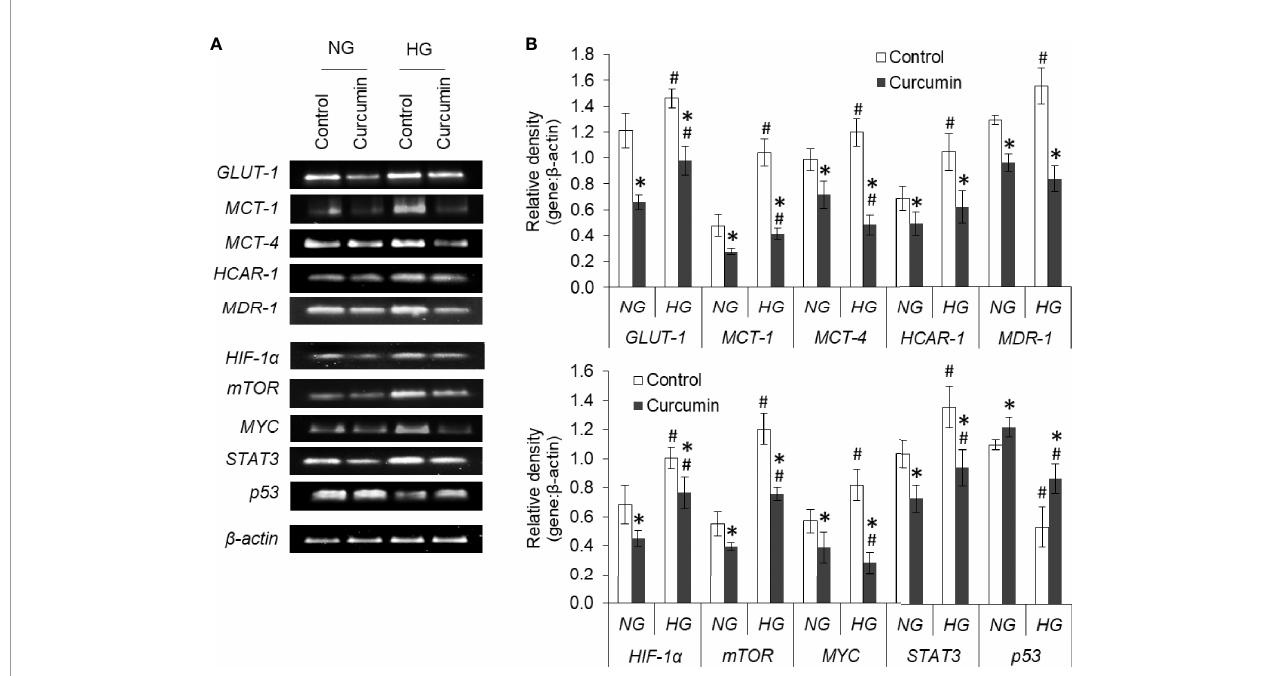
FIGURE 12 | Curcumin modulates the gene expression of regulators of metabolic and chemoresistance phenotype of cancer cells. Cells incubated in NG or HG medium with and without curcumin were processed for RT-PCR analysis for gene expression of regulators of metabolic and chemoresistance phenotype as indicated. The ampli fi ed DNA were resolved on Agarose gel, bands were visualized, and images of bands were captured (A) . Densitometric scan of bands were done, and relative intensity of bands against b -actin was calculated (B) . Bands shown are representative of three experiments conducted independently. The values shown are Mean ± SD of three independent experiments conducted in triplicate. * p < 0.05 vs values of cells of control group. # p < 0.05 values of cells incubated in NG